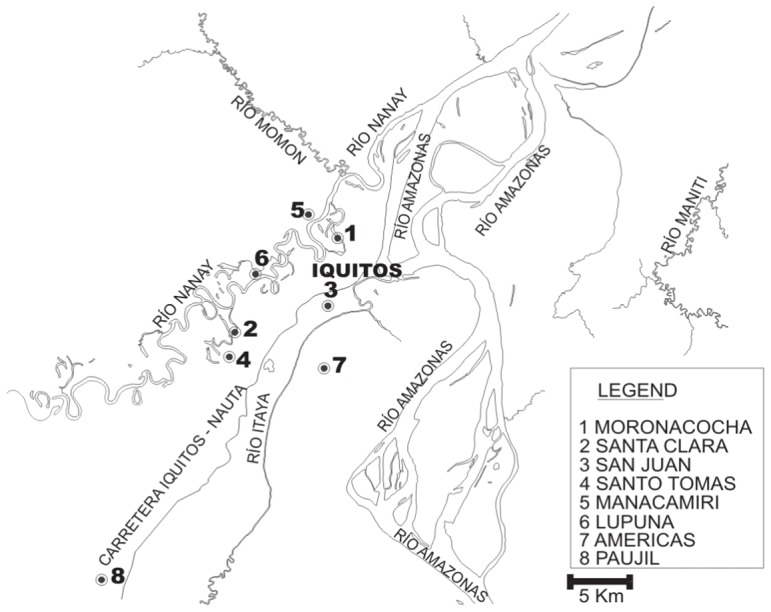
Map of included health centers.The village of Atalaya (−3.58, −73.75), located 59 km to the West of Iquitos, is not displayed on the map.